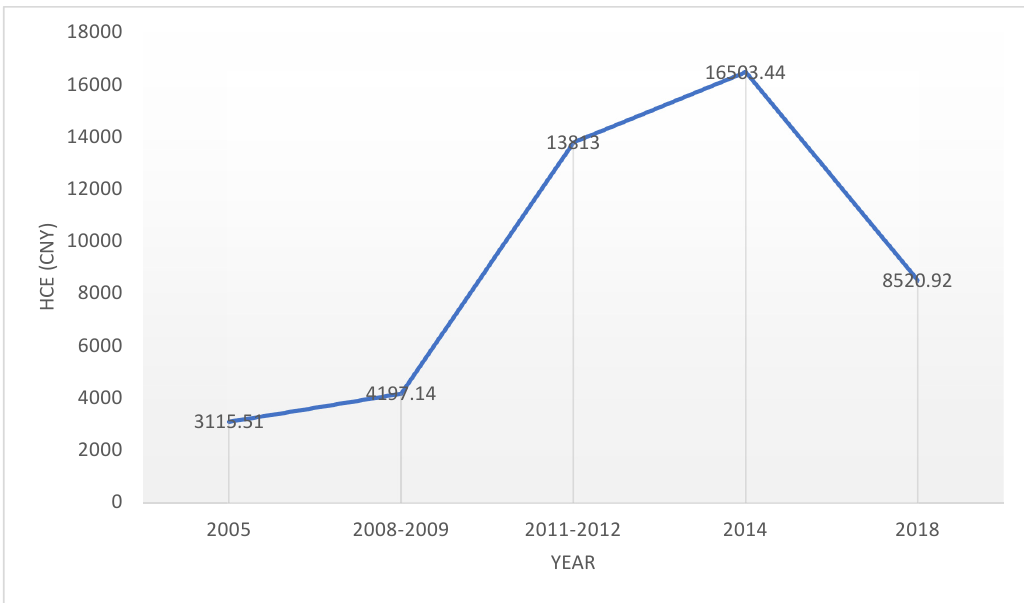
Figure 2. Elderly HCE in China (2005–2018).